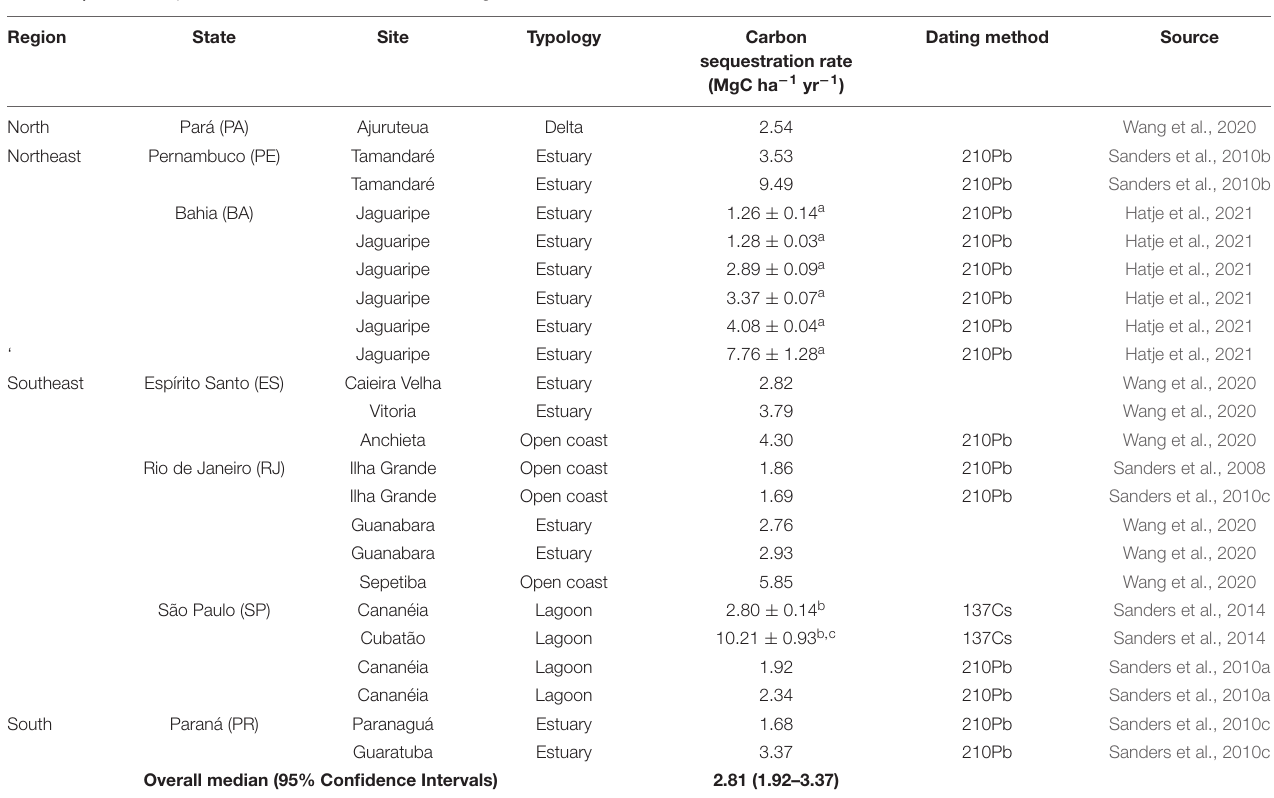
TABLE 4 | Carbon sequestration rates in soils for Brazilian